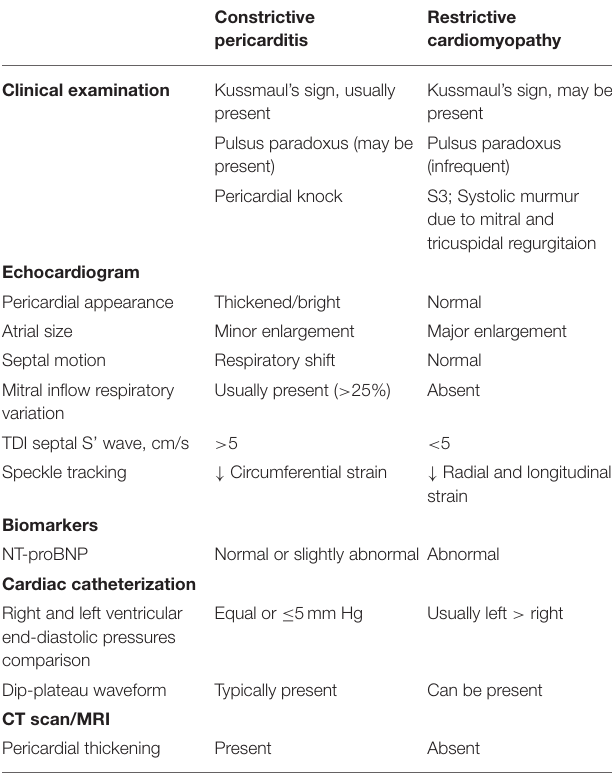
TABLE 1 | Differential diagnosis of constrictive pericarditis and restrictive cardiomyopathy.